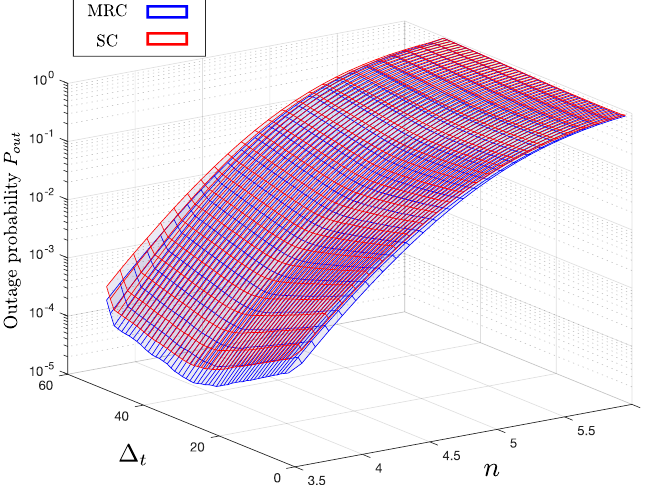
Figure 7. Outage probability P out with different ∆ t and n , when γ th = 10 − 3 , l = 30 m, P T = 50 dB, and σ = 8 dB.